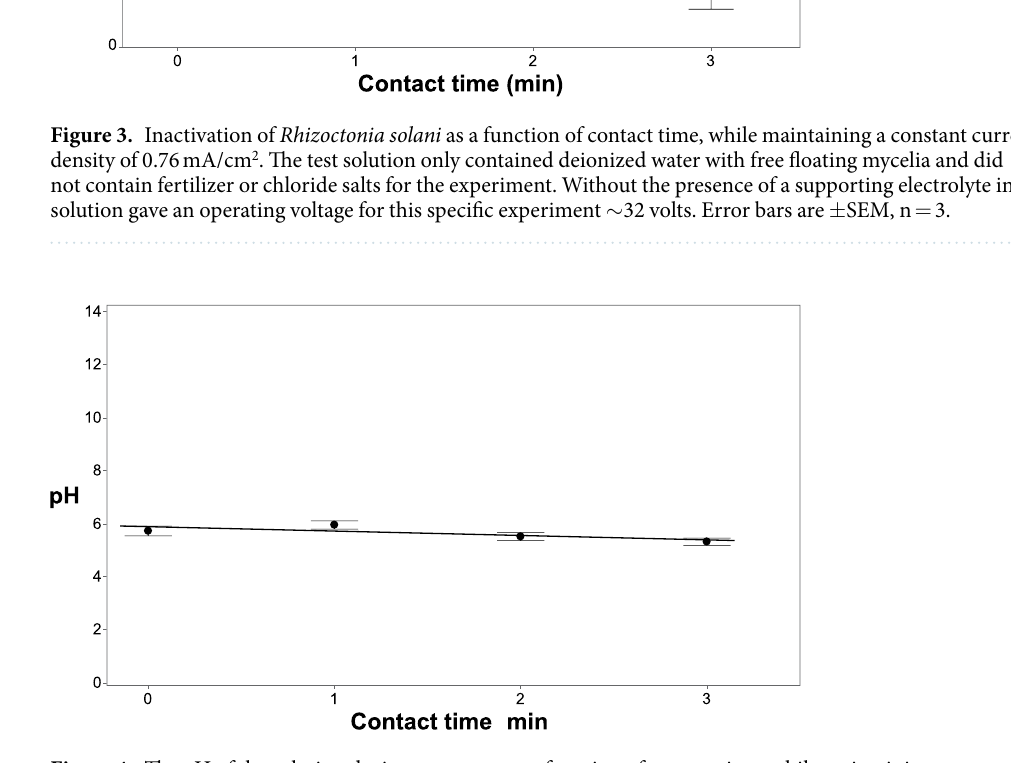
Figure 4. The pH of the solution during treatment as a function of contact time, while maintaining a constant current density of 0.76 mA/cm 2 . The test solution only contained deionized water with free floating mycelia and did not contain fertilizer or chloride salts for the experiment. Error bars are ± SEM, N =